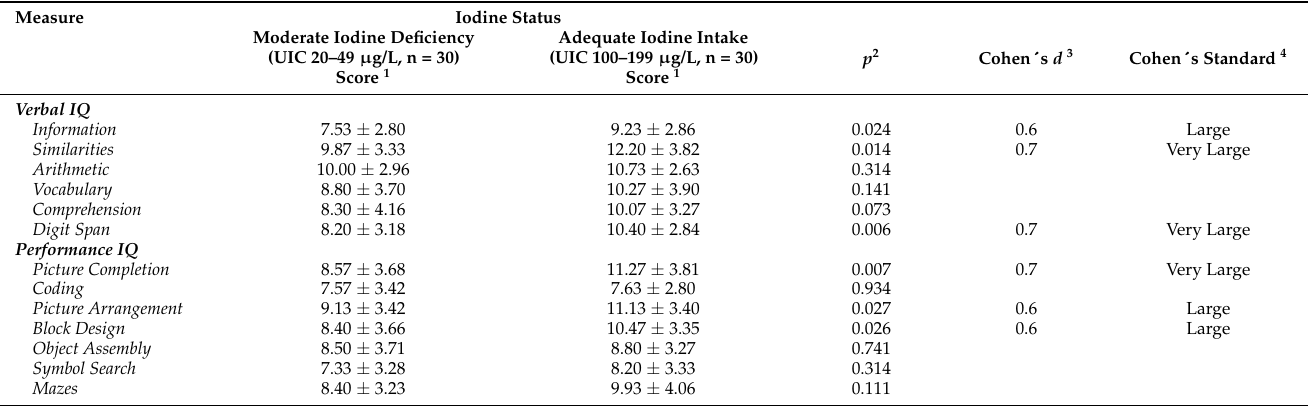
Table 3. Final mean percentile scores for each individual WISC-III cognitive subtests of verbal and performance IQ in schoolchildren for moderate iodine deficiency and adequate iodine intake